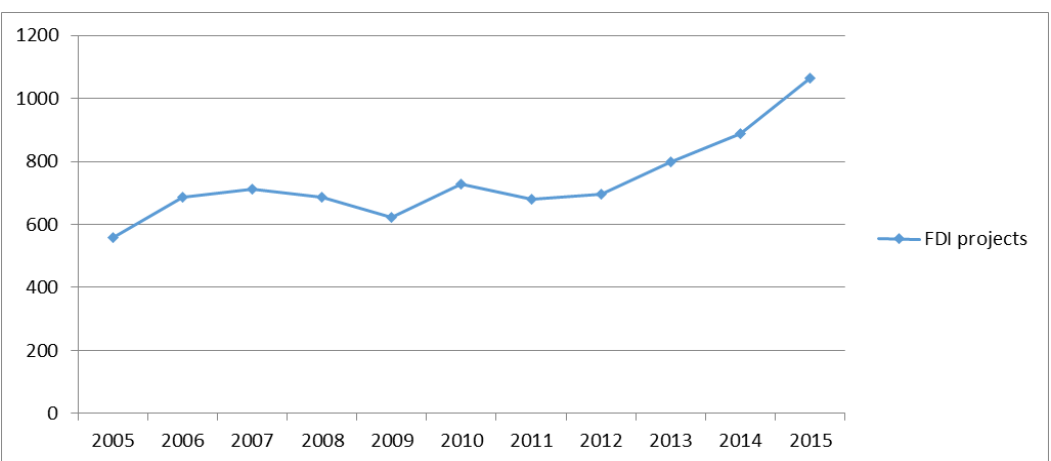
Figure 1: The evolution of the number of FDI inward projects in the UK over 2005-2015